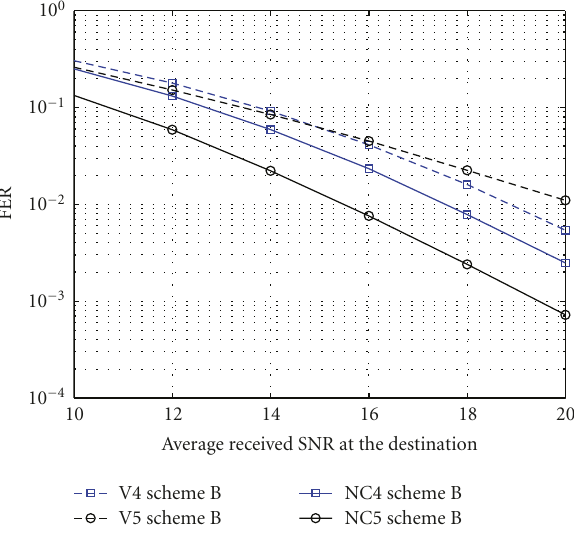
Figure 9: FER performances of new 8PSK codes for Schemes A and B (dSNR = 10dB).